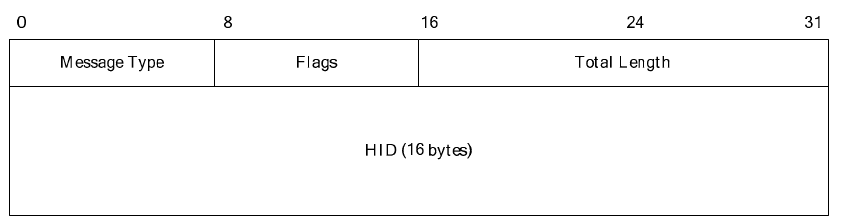
Figure 11. Structure of the control message.